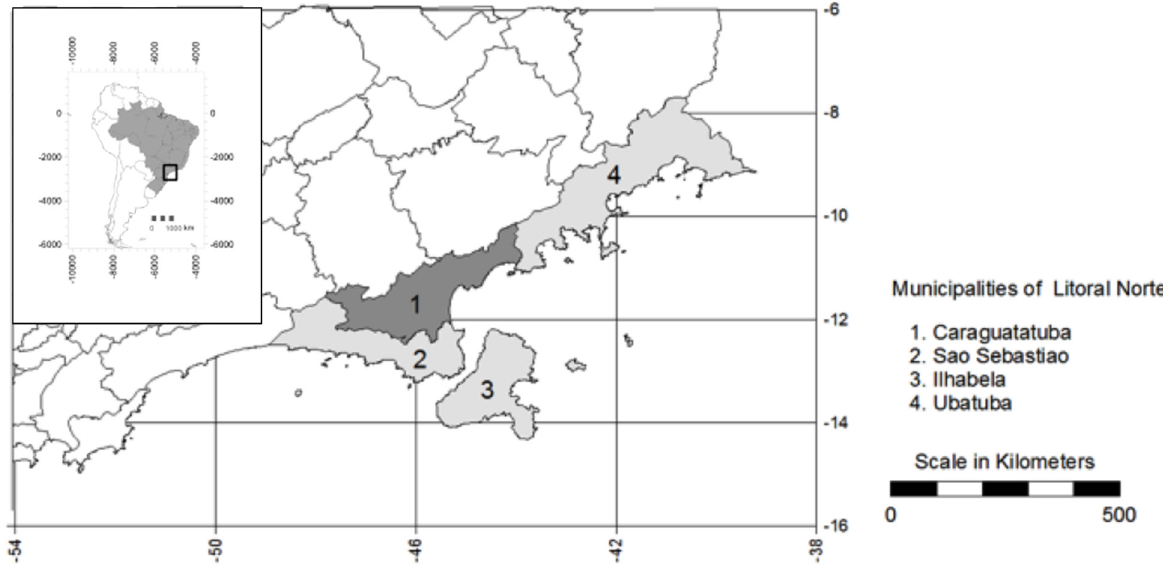
Figure 2. Caraguatatuba localization (Source: prepared by the